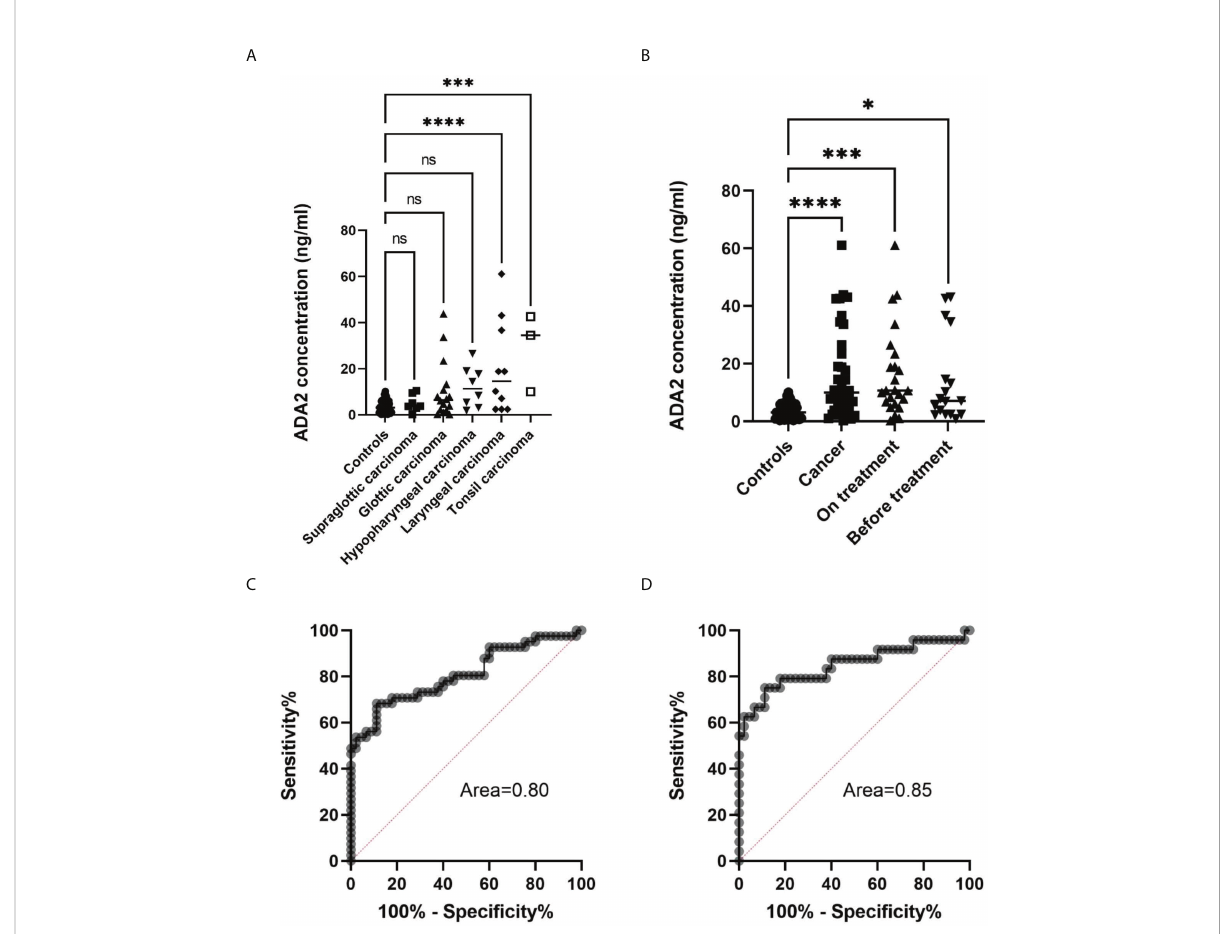
FIGURE 6 Analysis of saliva samples from head and neck cancer patients. (A) ADA2 concentration in saliva samples from healthy controls and patients with head and neck cancer types. ***p=0.0001, ****p<0.0001, according to one-way ANOVA test. (B) ADA2 concentration in saliva samples from healthy donors, all cancer patients, treated and not treated cancer patients. *p=0.01, ***p=0.0002, ****p<0.0001 according to one-way ANOVA test. (C) ROC curve constructed for all cancer samples (D) ROC curve constructed for samples from cancer patients undergoing treatment. The ADA2 concentrations were detected according to the method described in Figure 2. ns, non-signi fi